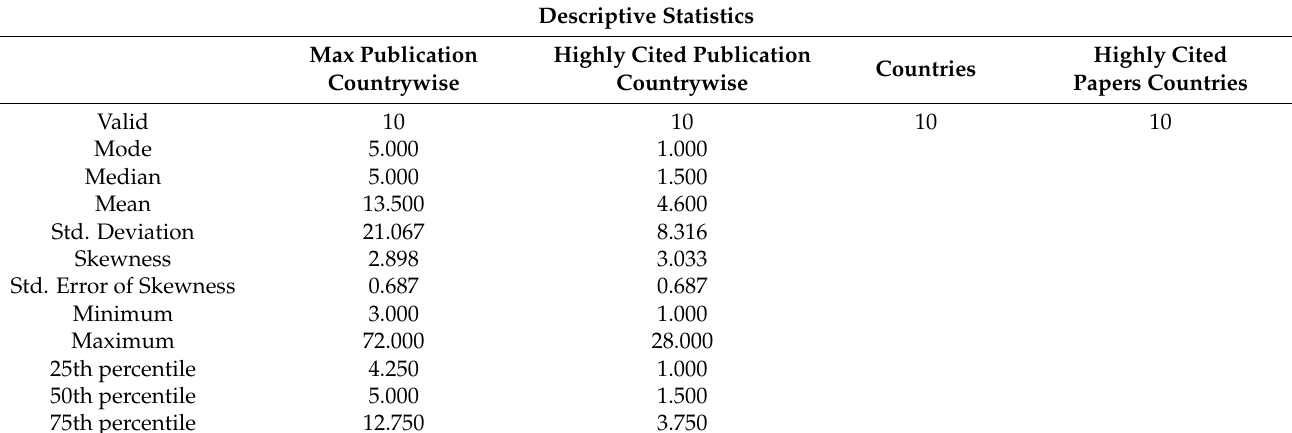
Table 7. Descriptive statistics of top ten countries in all and highly cited paper countries.